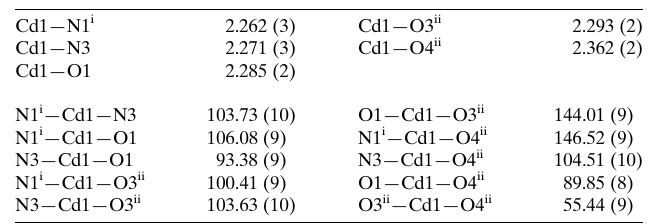
Table 2 Selected geometric parameters (A˚ , (cid:3) ) for 2 .